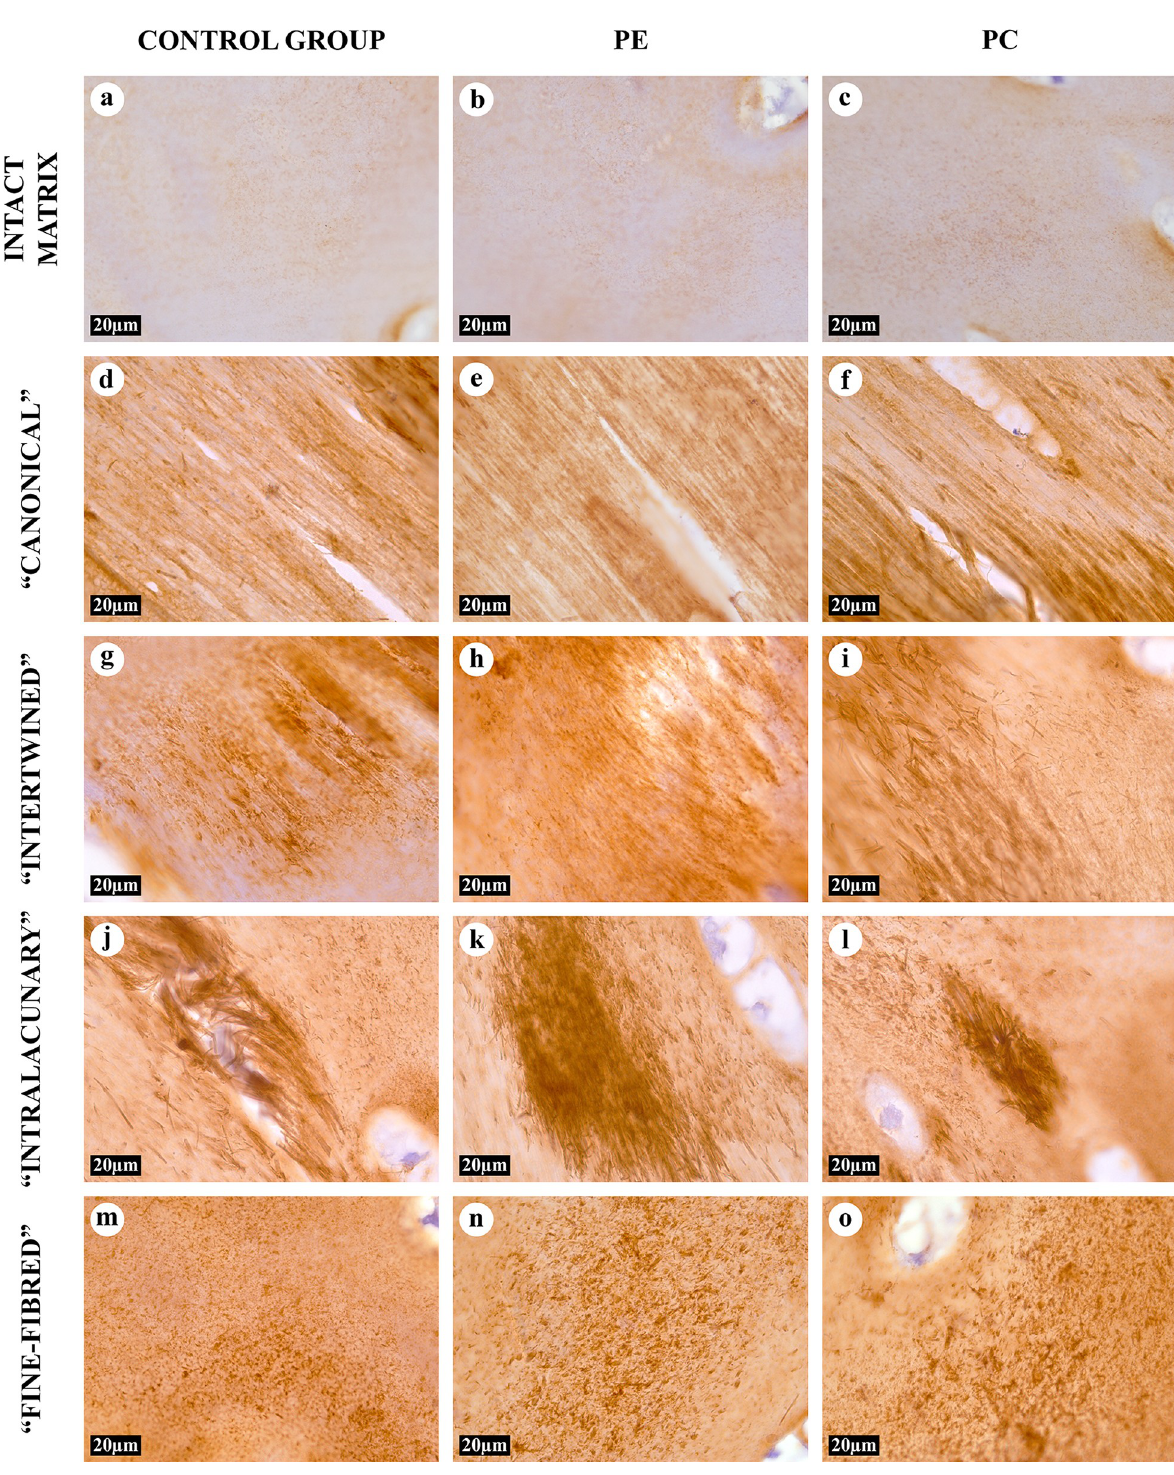
Fig 6. IHC study of the intact matrix and four types of AT areas, anti-collagen type II antibodies, 1000 × . Collagen type II was detected in chondrocytes and all types of matrix. The expression of collagen type II in the intact matrix (A-C) was relatively weak. The AFs in the “canonical” (D-F) and “intertwined” (G-I) types of AT areas had uneven staining intensity.